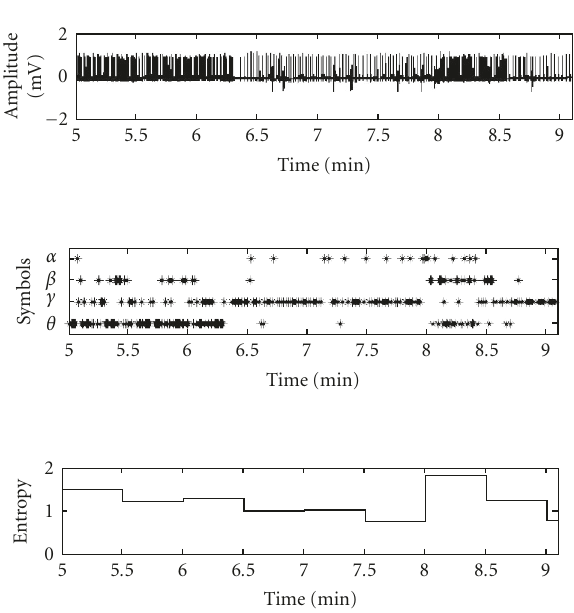
Figure 13: Raw ECG tracing, symbolic signal, and entropy taken over 30-second windows for a patient with atrial fibrillation. As in Figure 14, atrial fibrillation in the raw tracings corresponds to the dense